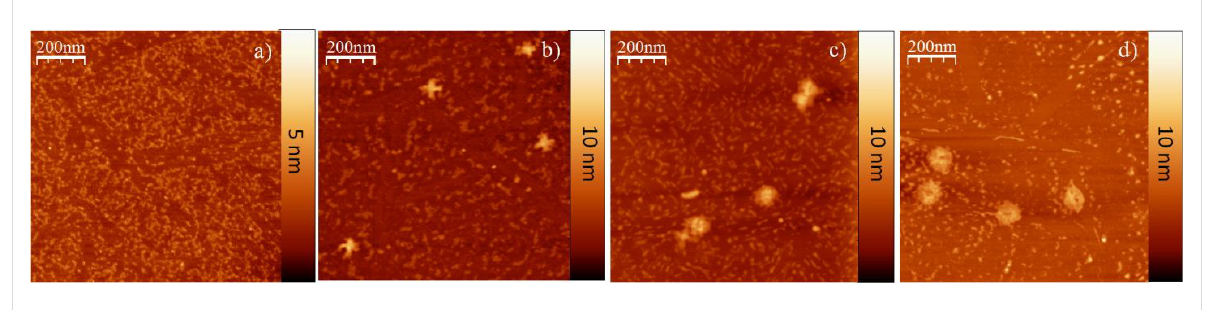
Figure 4: (a) MoS 2 substrate incubated with a 0.5 mM pyrene–methanol solution for 5 min. (b) Cross-shaped DNA origami nanostructures deposited on MoS 2 pre-treated with pyrene and immediately imaged by AFM in air. The AFM images were also recorded after 24 h (c) and 48 h (d). The observed DNA origami structure degrades over